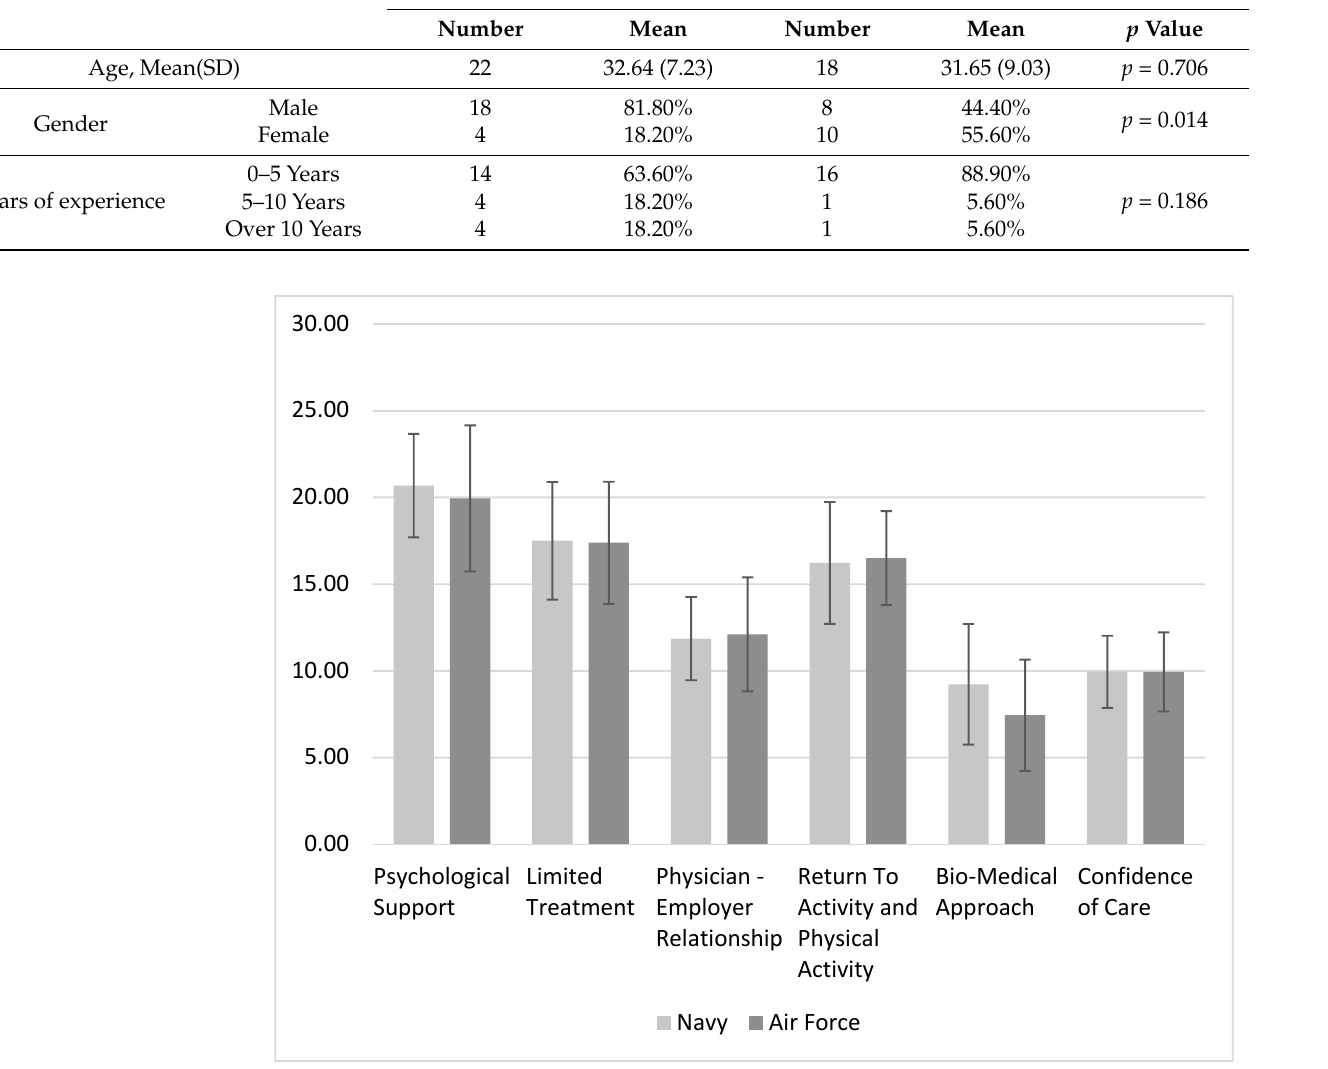
Figure 1. ABS-mp’s mean scores for every sub-scale before the ETMI workshop in both physicians’ groups. No significant differences were observed between groups.